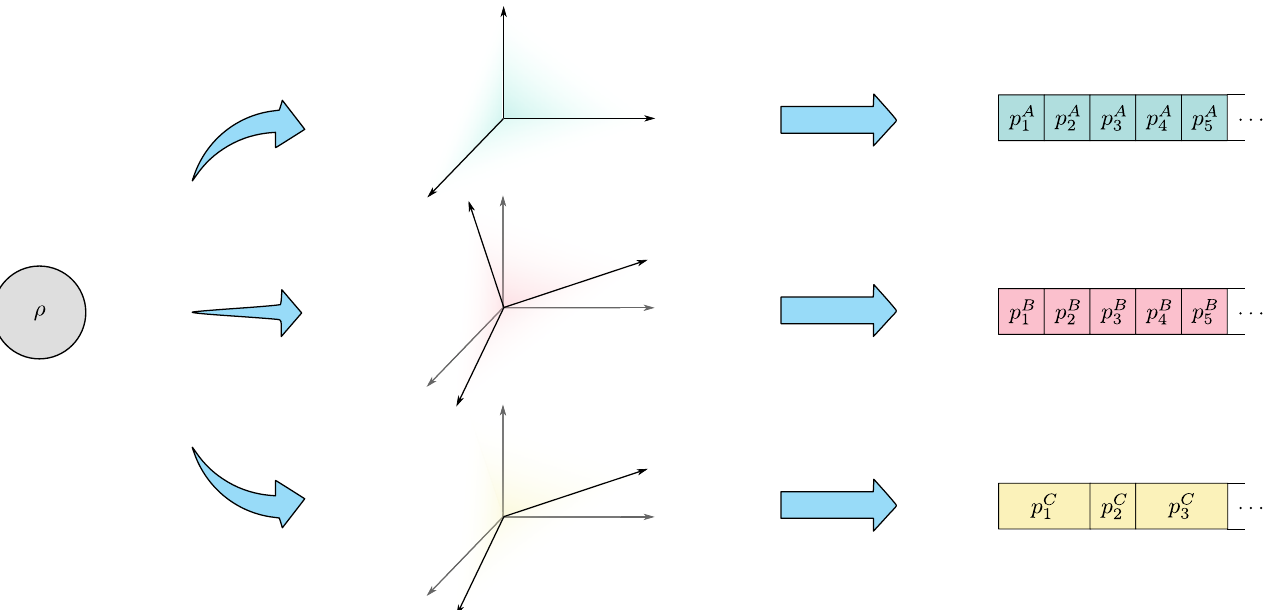
Figure 2. Representation of the probability distribution used in the de fi nition of quantum logical entropy. Any state q , together with a partition characterized by a PVM, which is associated with an orthonormal basis in the corresponding Hilbert space, de fi nes a probability distribution. This is the case even in case of coarse (i.e., degenerate) PVMs, as illustrated by the yellow partition. These distributions allow the introduction of (PVM-dependent) logical entropies for quantum